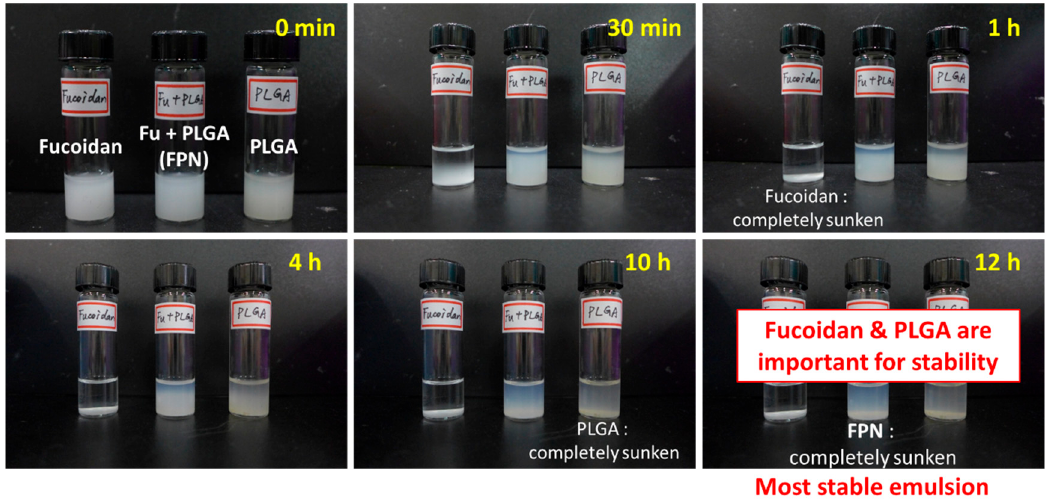
Figure 1. Observation of variation in emulsions containing fucoidan alone (Fucoidan), fucoidan accompanying PLGA (Fu + PLGA), and PLGA alone (PLGA) over time from the left to the right bottle in each